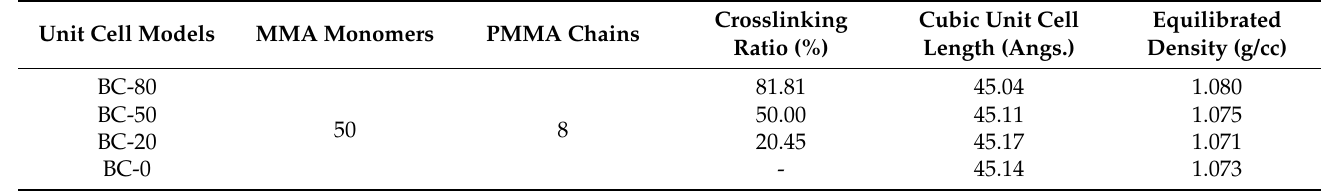
Table 1. The details of the modeled PMMA microstructures.